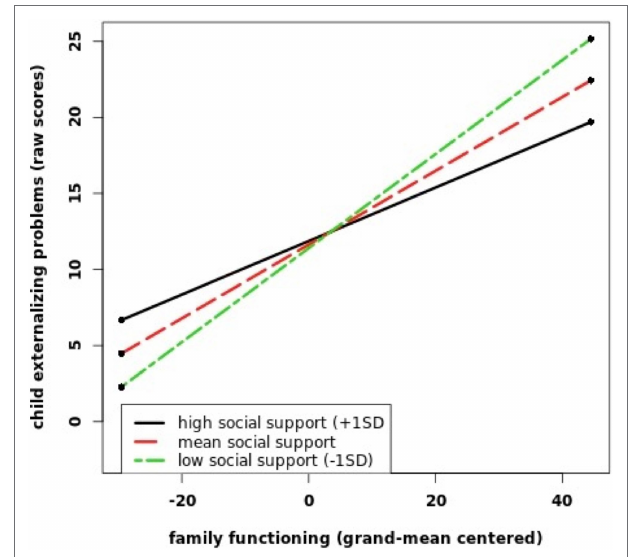
FIGURE 2 | This figure shows the interaction between FBA and OSSS on child externalizing problems (YSR) from the children’s perspective. The values for FBA and OSSS are grand-mean